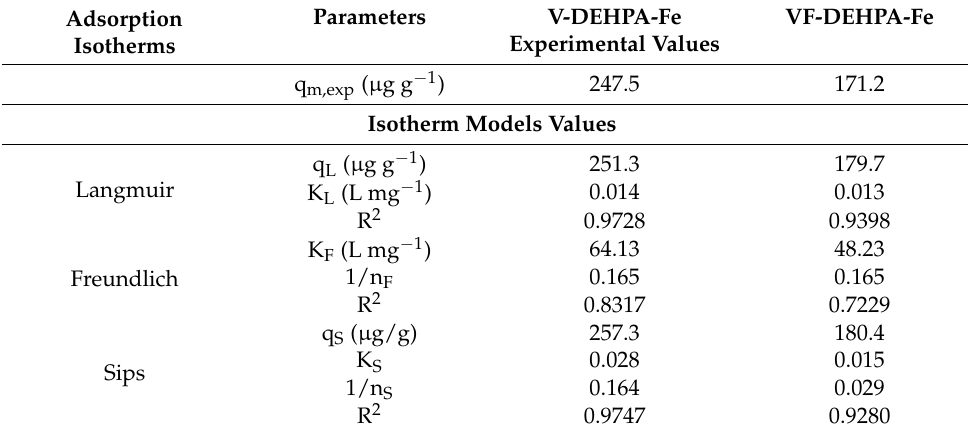
Figure 12. Adsorption isotherms of As(V) onto functionalized materials ( a ) V-DEHPA-Fe and ( b ) VF-DEHPA-Fe. Table 4. Parameters of Freundlich, Langmuir and Sips isotherms for As(V) adsorption onto function- alized